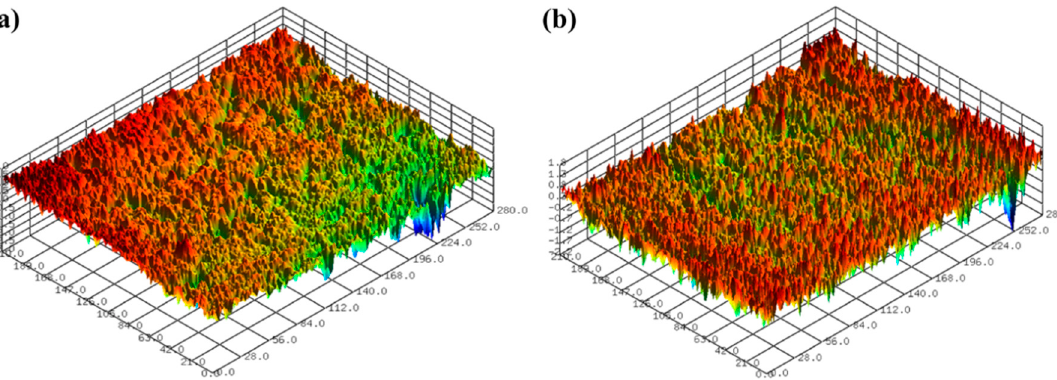
Figure 8. Surface roughness and glossiness of 3D-printed ABS-like resin before and after sanding.